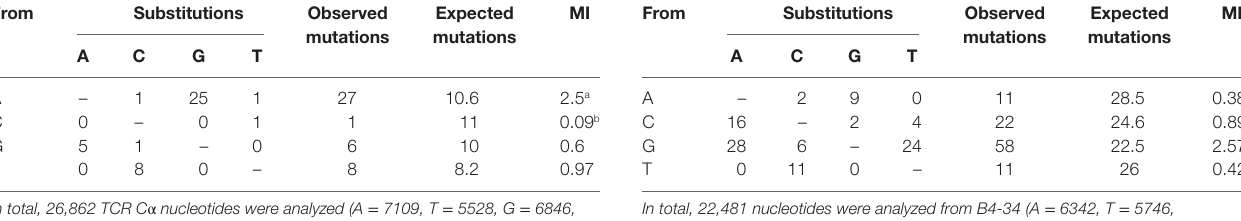
expected mutations mutations